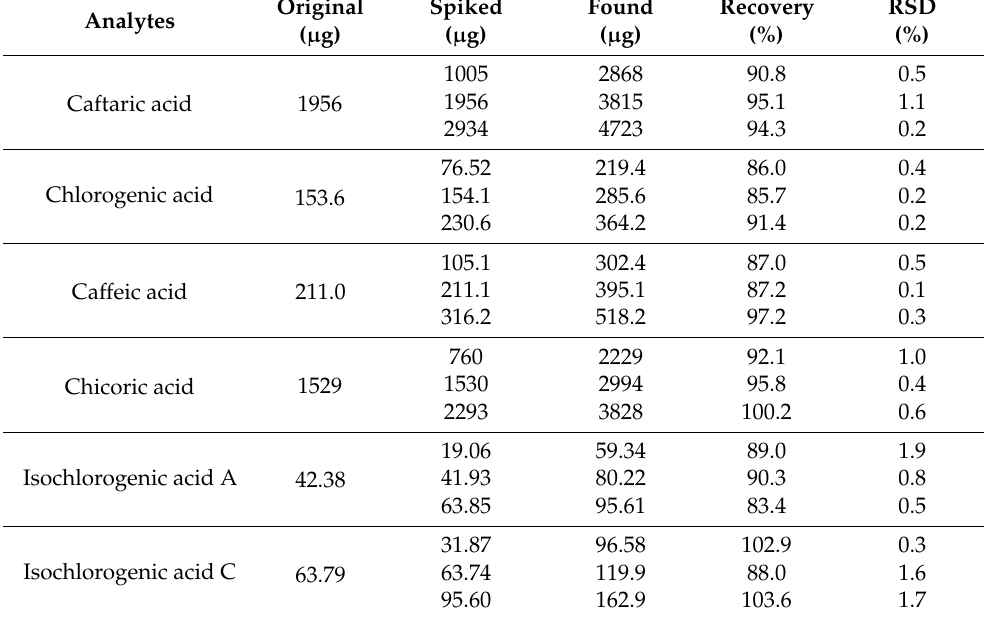
Table 9. Recoveries of the quantification method validation ( n = 9).